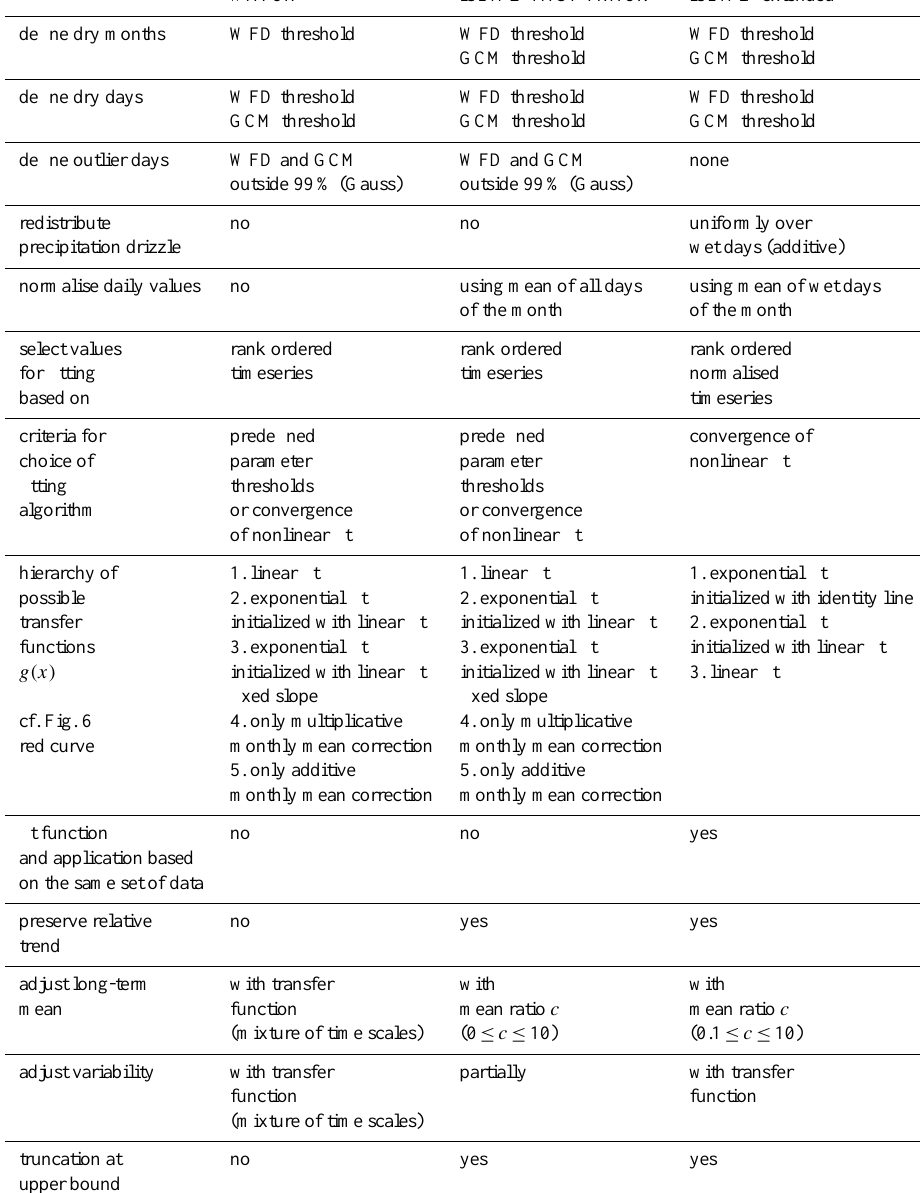
Table 2. Comparison of bias correction algorithm for precipitation (multiplicative approach), main algorithmic steps. WATCH ISI-MIP FAST-TRACK ISI-MIP